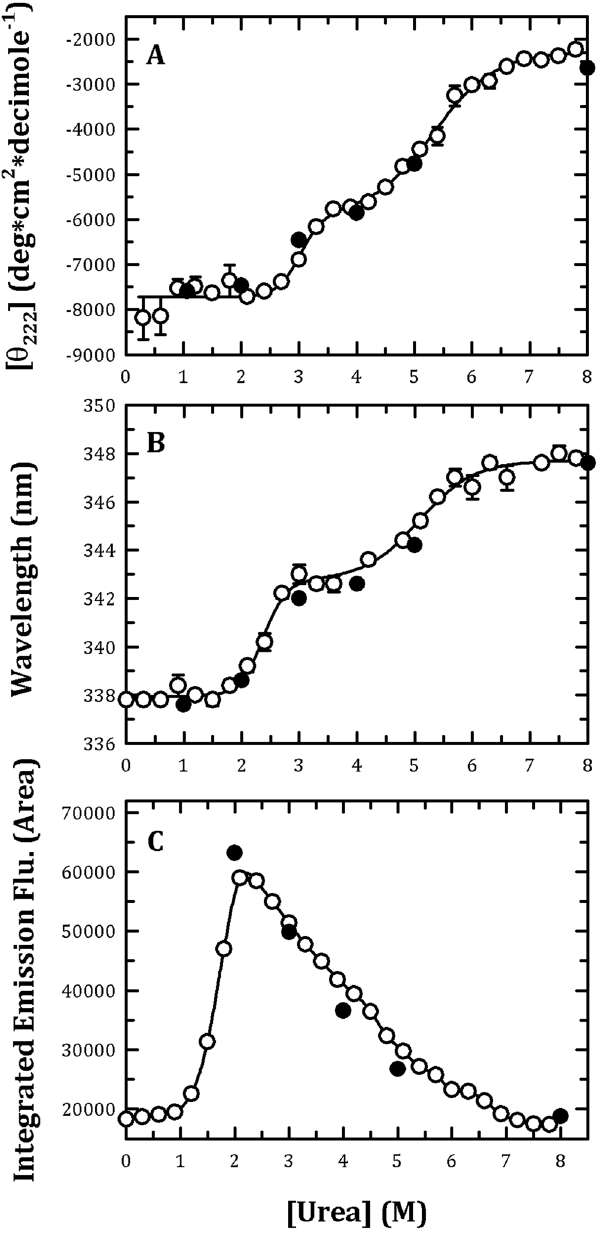
Figure 2. Monitoring of the urea-induced unfolding and refolding of human PAD4 WT enzyme by CD spectrometry and the intrinsic protein fluorescence. The PAD4 WT enzyme in the presence of 10 mM Ca 2 + was treated with various concentrations of urea in 50 mM Tris-HCl buffer (pH 7.4) at 25 °C for 16 h and then monitored through CD spectrometry ( A ), fluorescence ( B ) or ANS fluorescence ( C ). Open circles: the PAD4 enzyme was denatured with different concentrations of urea. Closed circles: the PAD4 enzyme was completely denatured with 8 M urea and then renatured by diluting the urea concentration to 5, 4, 3, 2 and 1 M, as indicated in the figures. The experimental data in ( A , B ) were fitted by either a two-state or three-state model. The fit results and residues are shown as a solid line with error